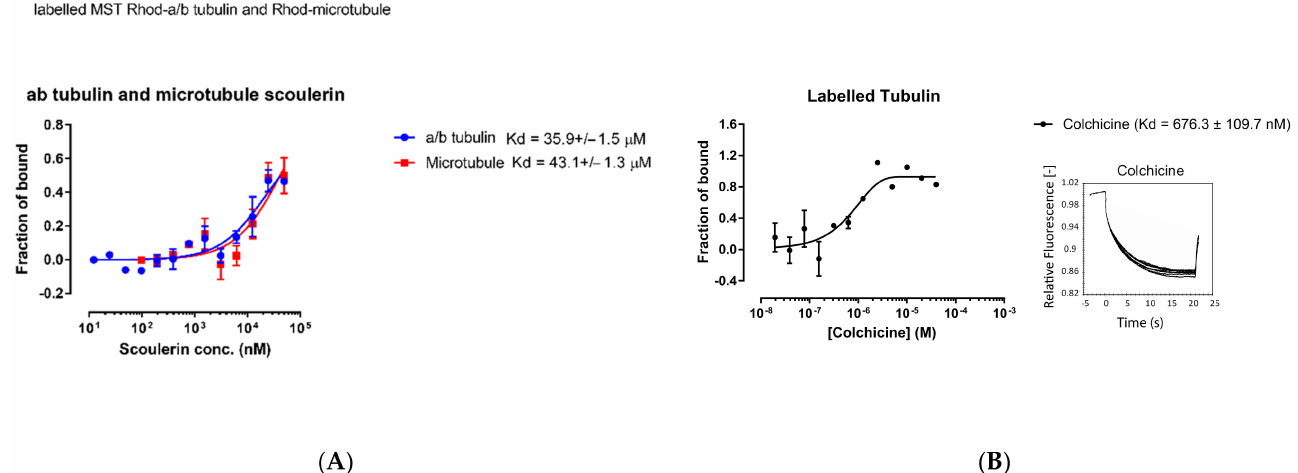
Figure 17. ( A ) Purified porcine αβ tubulin (colchicine binding site, blue circle) and microtubule (laulimalide binding site, red square) binding to scoulerine via microscale thermophoresis. Each data point represents the mean of two independent measurements and the error bar is shown as the standard deviation. The binding curve is fitted with Graphpad Prism 7.0. ( B ) Fluorescence labelled purified porcine α / β tubulin binding to colchicine. Normalized microscale thermophoresis time traces are shown on the right. Each data point is the mean of three independent microscale thermophoresis measurements; error bars represent the standard deviation. The binding curve is fitted with Graphpad Prism